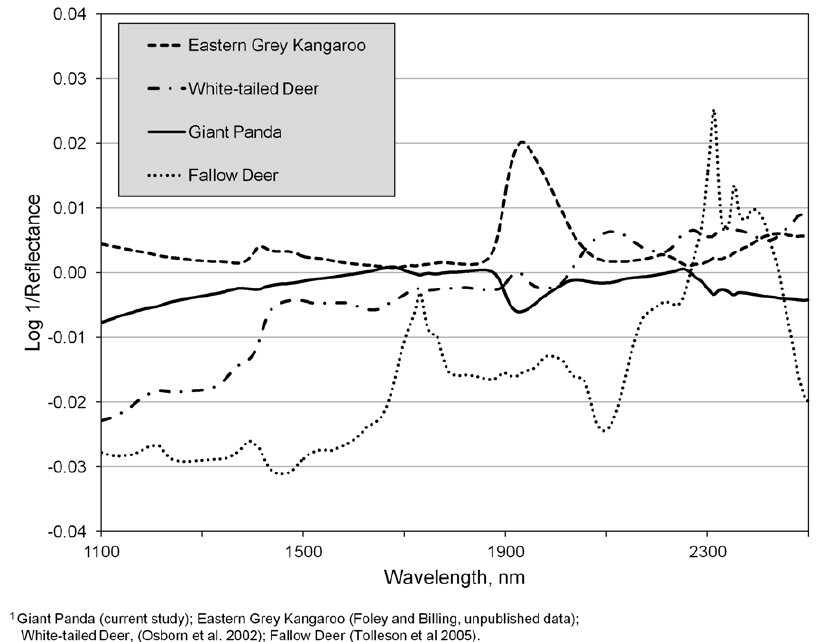
Figure 4. Fecal near infrared difference (male – female) spectra (log 1/reflectance, derivative=0, gap=0) from four different herbivore species.